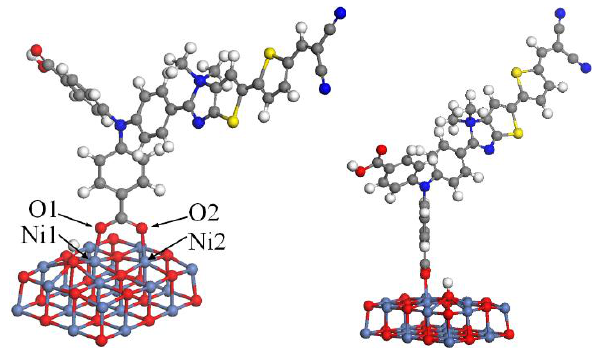
Figure 7. Adsorption of T2N+1-d on (NiO) 10 × 2.